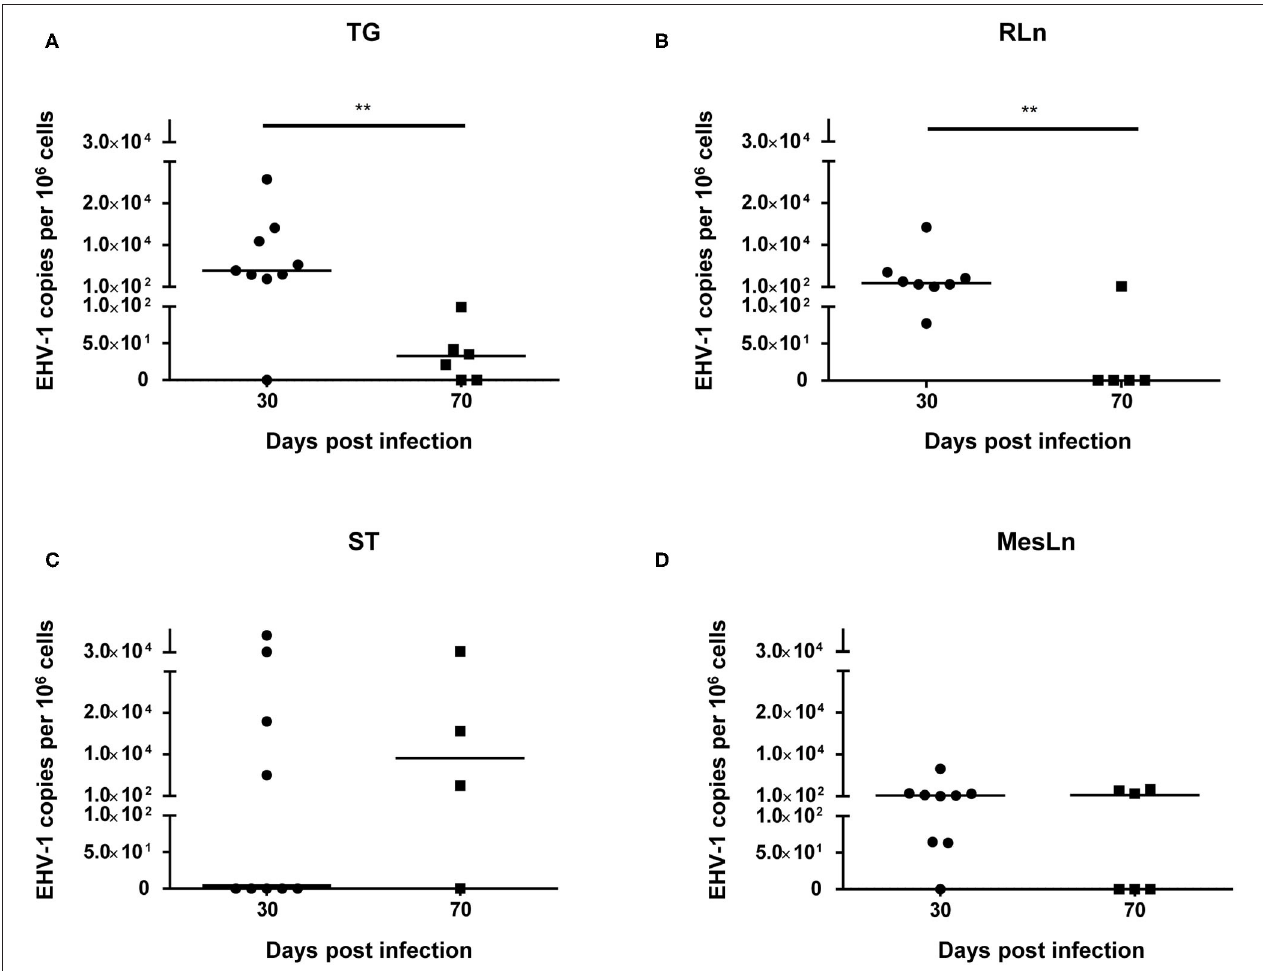
FIGURE 1 | Significant differences (** P < 0.01) in viral copy numbers in (A) trigeminal ganglia and (B) retropharyngeal lymph nodes at 30 dpi compared to 70 dpi. Viral copy numbers in (C) sympathetic trunk and (D) mesenteric lymph nodes at 30 dpi compared to 70 dpi. Line indicates the